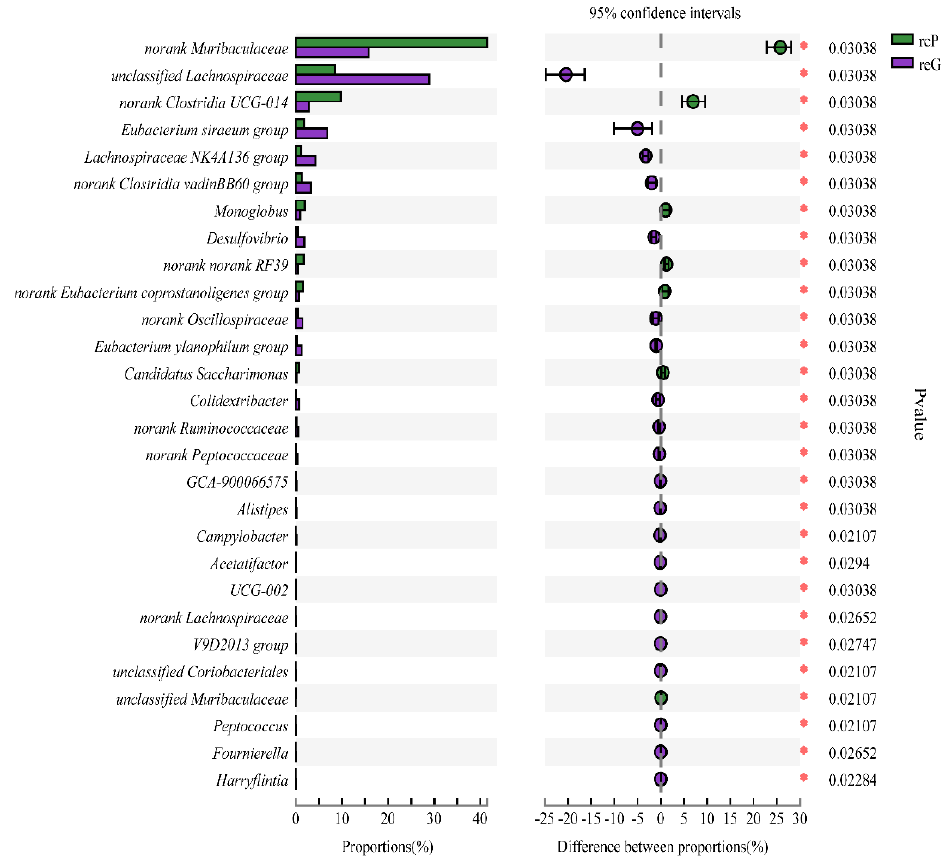
Figure A5. Wilcoxon rank–sum test bar plot at the genus level for the comparison of the microbiota in the rectum. The relative abundances of 28 genera were tested and found to be significantly different between the reP and reG groups. * 0.01 < p < 0.05.